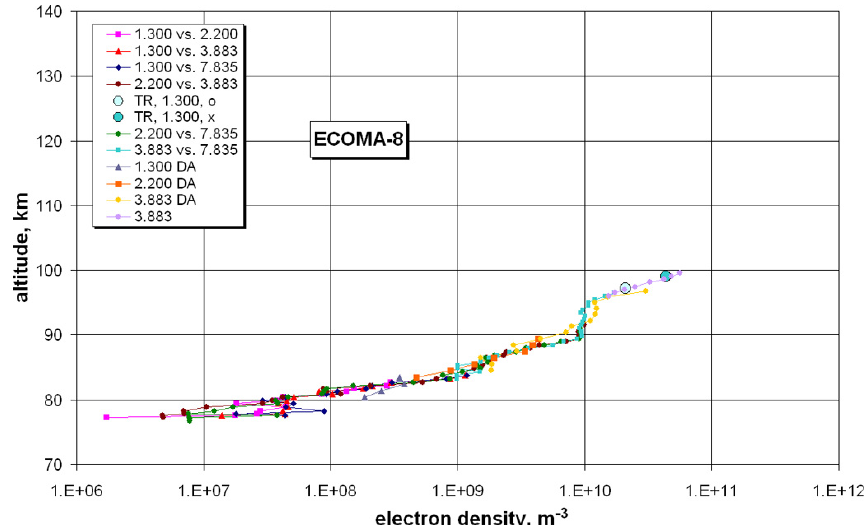
Fig. 5. Electron densities from various sources of the radio wave propagation experiment (flight ECOMA-8). When the rocket was at 100km, the 7.835MHz ground transmitter failed, and the three lower frequencies were all either absorbed or reflected (TR: total reflection [o and x modes]; DA: differential absorption).